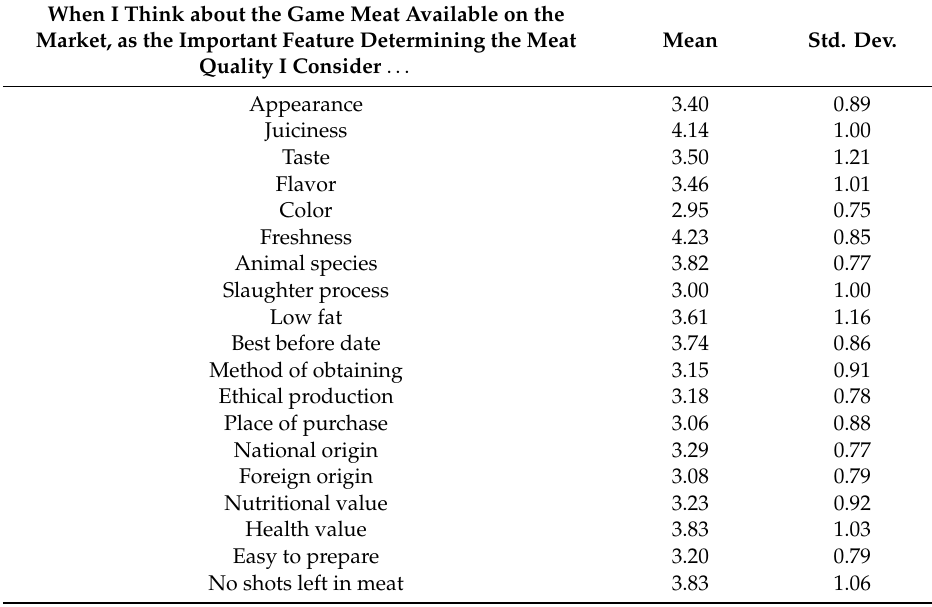
Table 3. Rational motives for game choice connected with quality